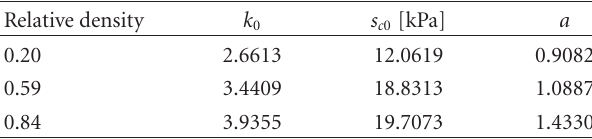
Table 3: Parameters in nonlinear yield function.